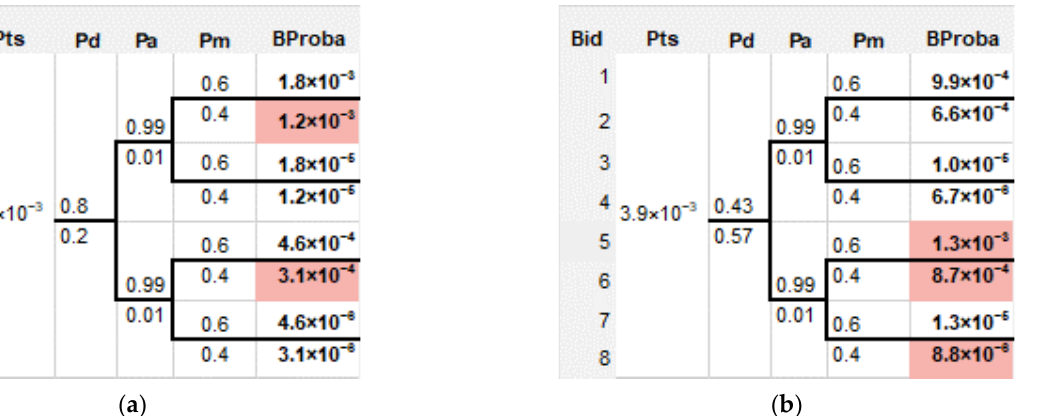
Figure 20. Event trees for the intrusion of an unauthorized drone in LIMC 35 departure path when takeoff is occurring [14]. ( a ) <1 km from runway. ( b ) >1 km from runway.